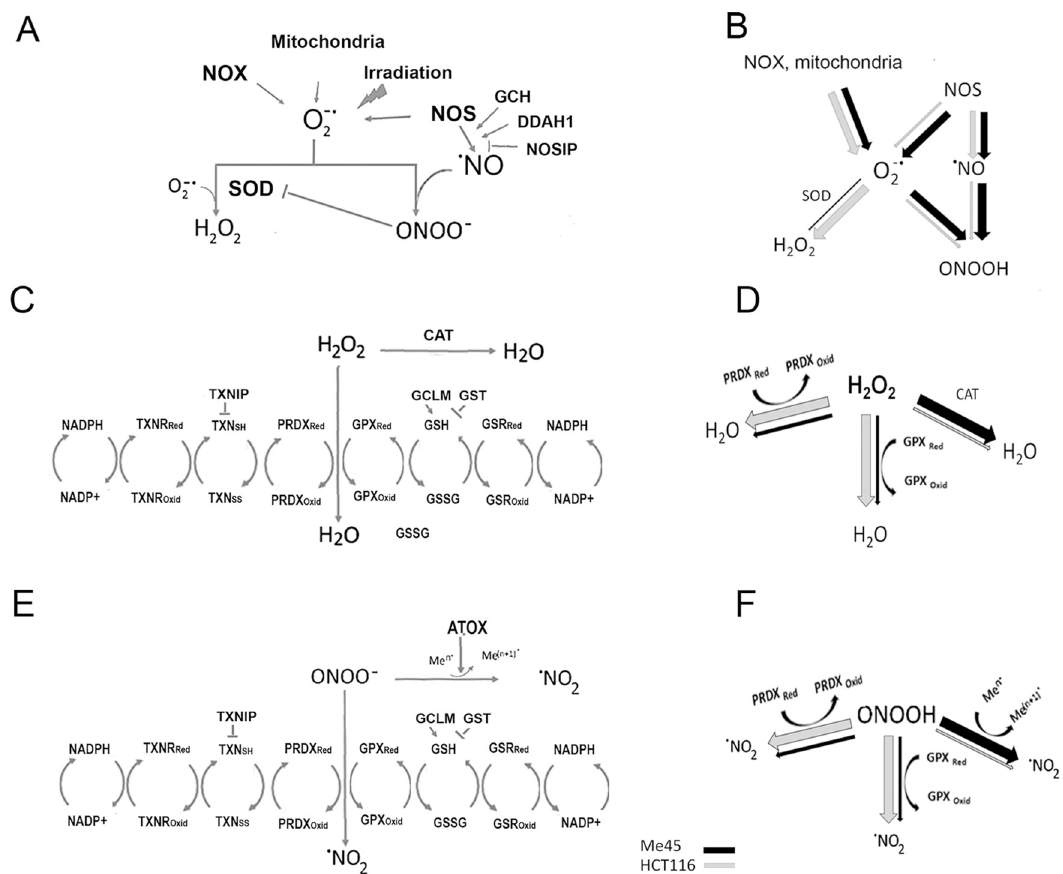
Fig 7. The main pathways for regulation of superoxide and NO levels in Me45 and HCT116 cells. A,C and E show production and further interactions of superoxide (A), hydrogen peroxide (C) and peroxynitrite (E) and regulatory pathways engaged. B,D and F compare use of presented regulatory pathways in HCT116 and Me45 cells by the size of black (Me45) and white (HCT116)